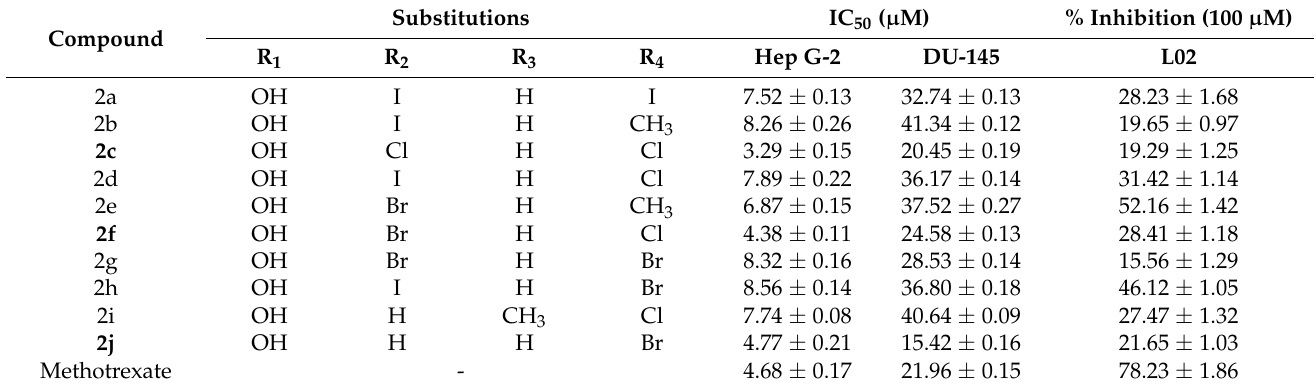
Table 3. Anticancer activity of compounds 2a–j in selected experimental human cancer cell lines.